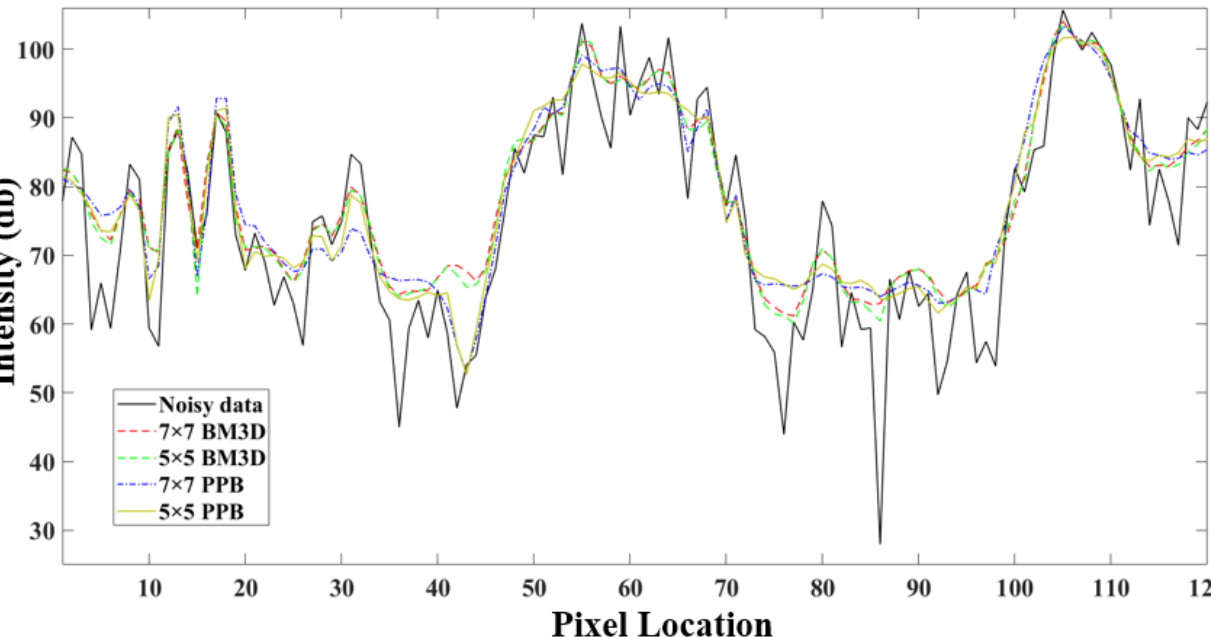
Figure 7. The profiles of a line across the lake in the TerraSAR-X image after despeckling by the different filters.